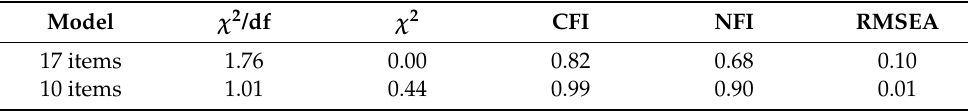
Table 3. Fit indexes for Confirmatory Factor Analyses.